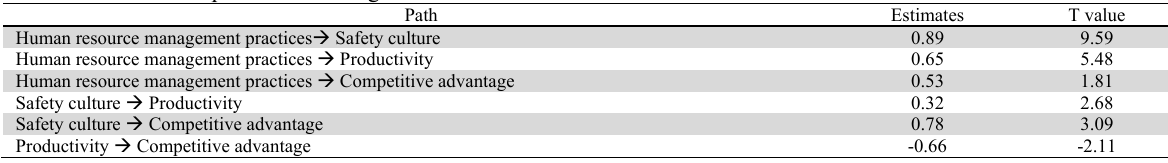
Direct Effects of Competitive Advantage